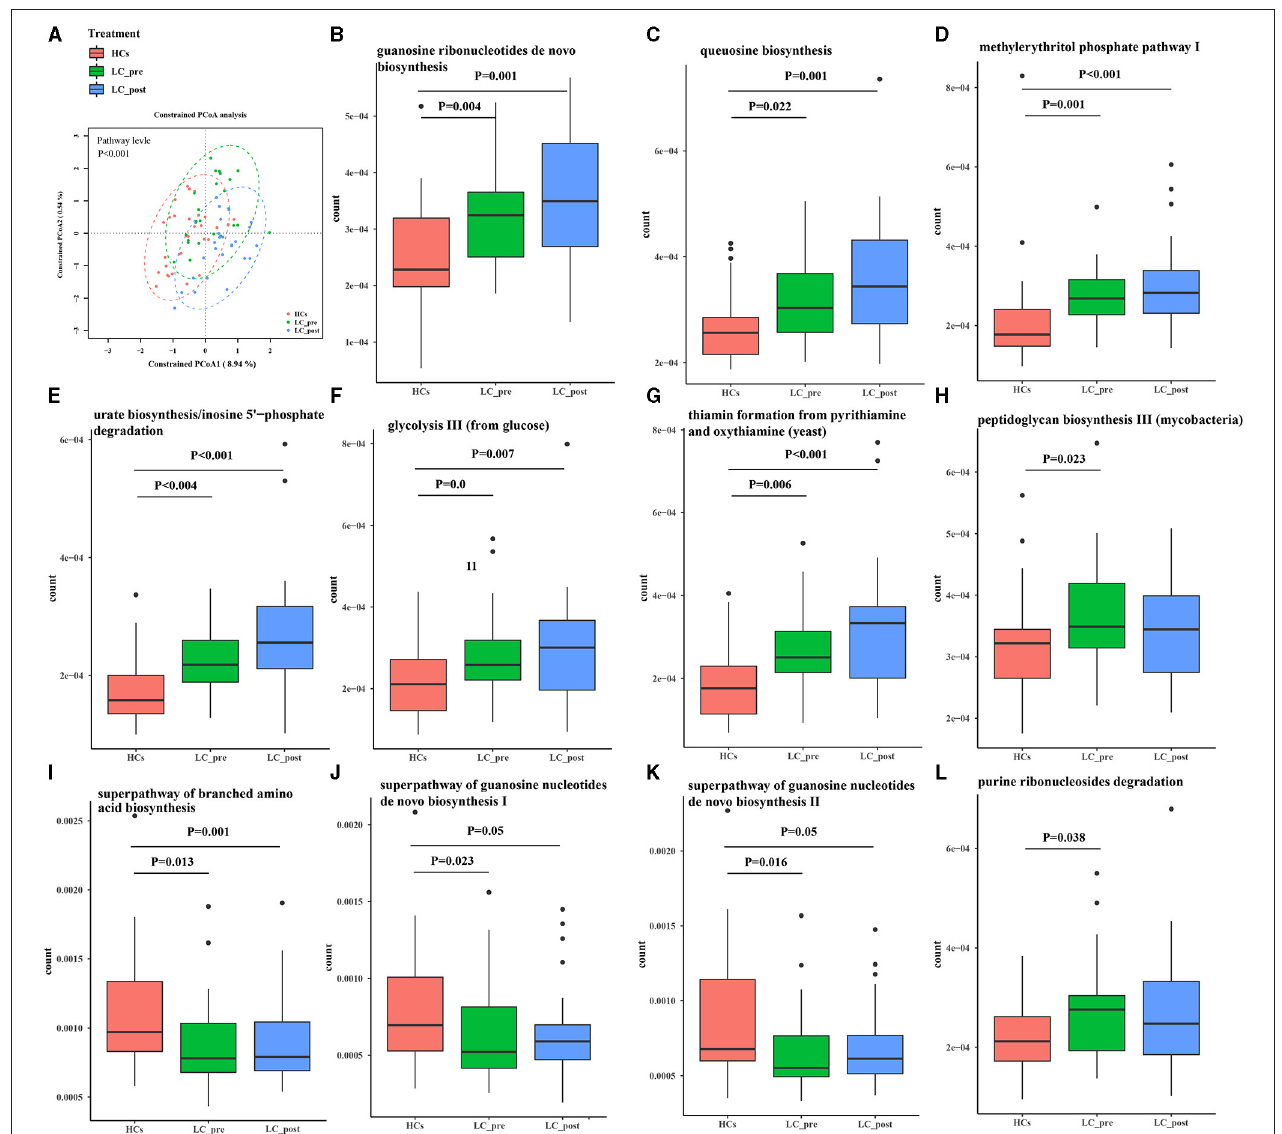
FIGURE 2 | Functional pathways of the gut microbiome in cirrhotic patients before (LC-pre, green) and after (LC-post, blue) lactitol intervention and healthy controls (HCs, red). The pathways were annotated by HUMAnN2. (A) Beta diversity analyses of the Bray–Curtis similarity index scores of microbial pathways between the three groups, and statistical significance was measured using adonis analysis. Ellipses show 95% confidence intervals, and the different colors of ellipses represent different groups. (B–L) Wilcox test of the top 50 microbial metabolic pathways between groups. Data were shown as box plots with the median and 25th to 75th percentiles. Benjamini–Hochberg correction was further applied to adjust derived p -values. Only pathways with p-values under a threshold of 0.05 were considered as